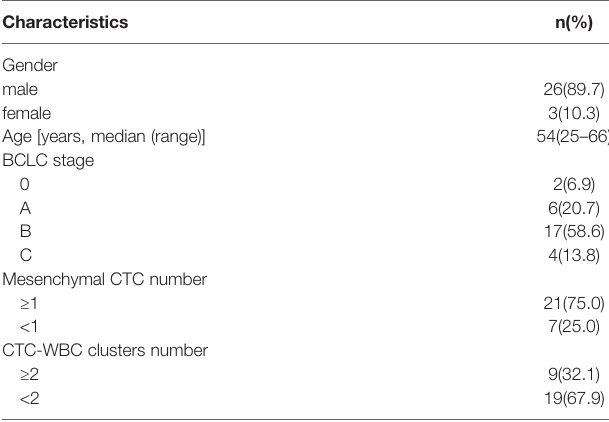
TABLE 1 | Patient characteristics.